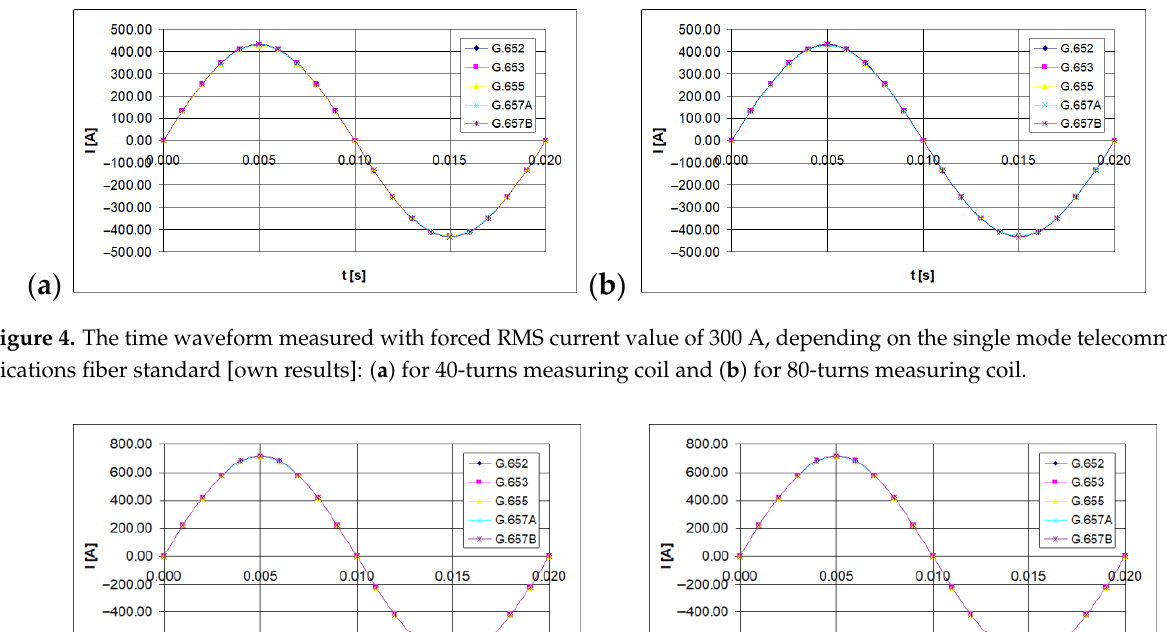
Figure 3. The time waveform measured with forced RMS current value of 100 A, depending on the single mode telecom- munications fiber standard [own results]: ( a ) for 40-turns measuring coil and ( b ) for 80-turns measuring coil.